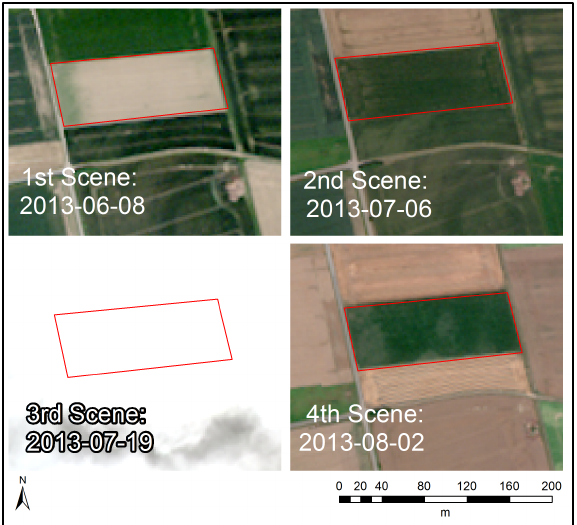
Figure 2. Overview of the area of interest on the four satellite scenes. Note the cloud cover on the 3 rd scene which made any analysis impossible.